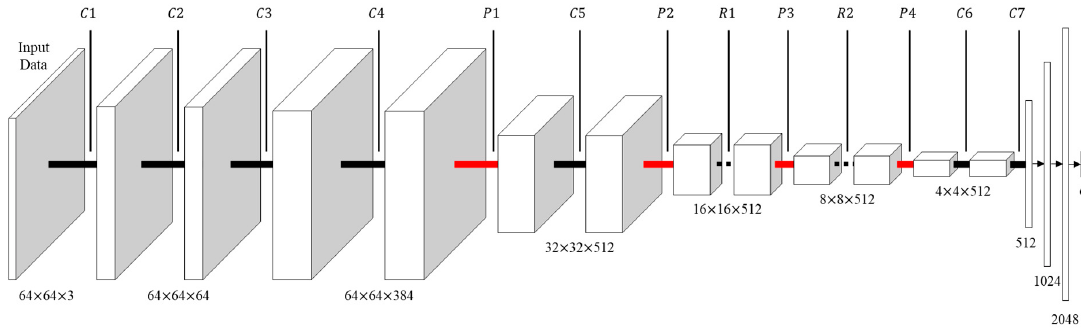
Figure 9. Structure of a single-stream CNN.